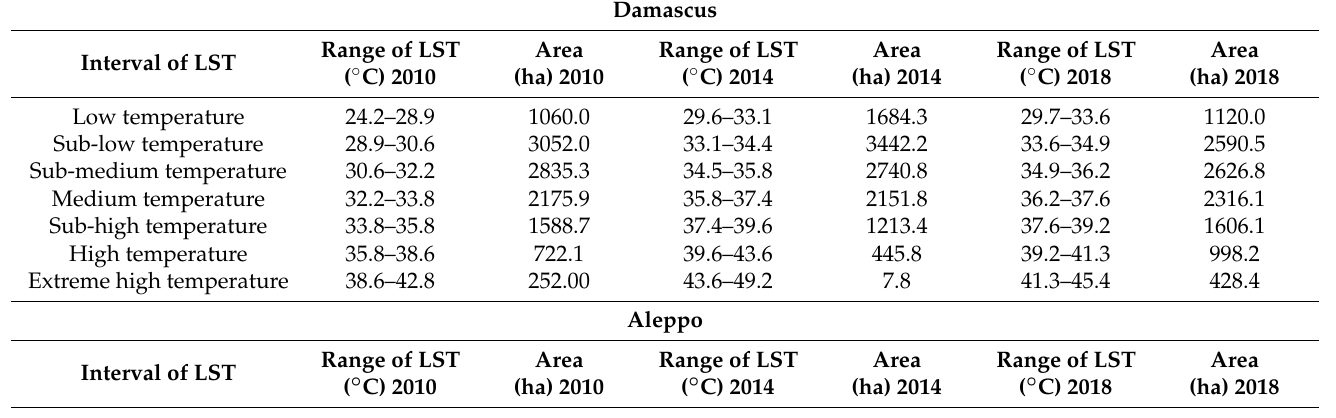
Table 7. LST interval values ( ◦ C) and corresponding LULC size (ha) during the analyzed time period. Damascus